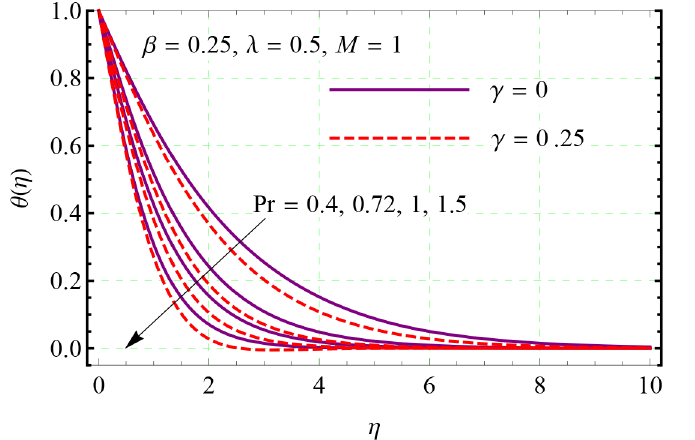
Fig 10. Effect of Pr and γ on θ ( η